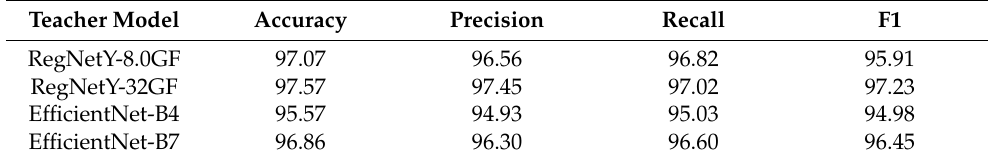
Table 4. Performance of the teacher models.